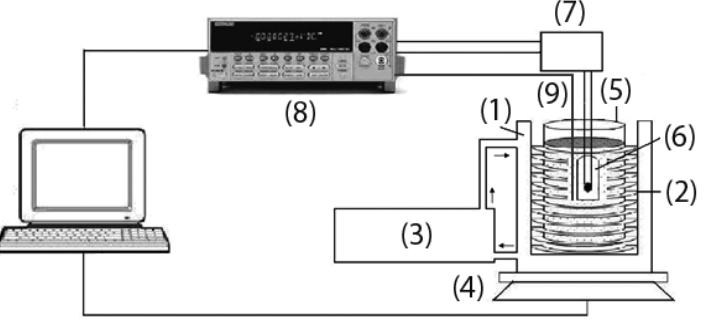
Figure 2. Scheme of the laboratory system for soil water content